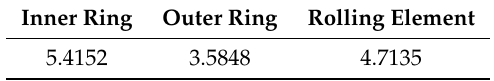
Table 3. Defect frequencies (multiple of running speed in